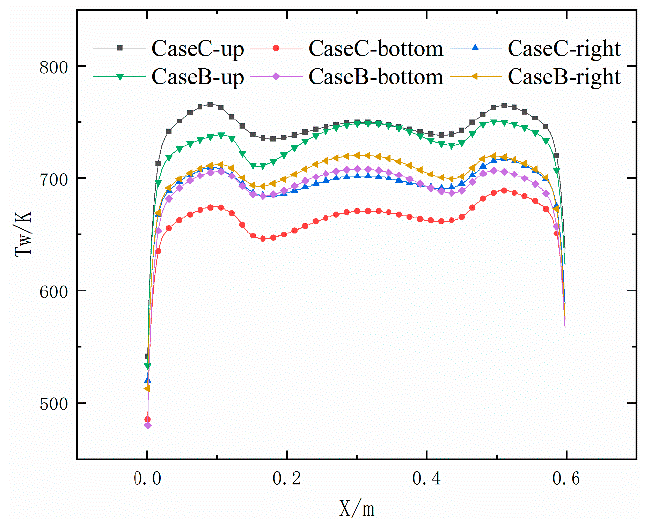
Figure 14. Comparison of the wall temperature distribution along the X-axis in case B and case C. Two-dimensional streamlines at Z = 2 mm visualized under a uniform magnitude are shown in Figure 15.